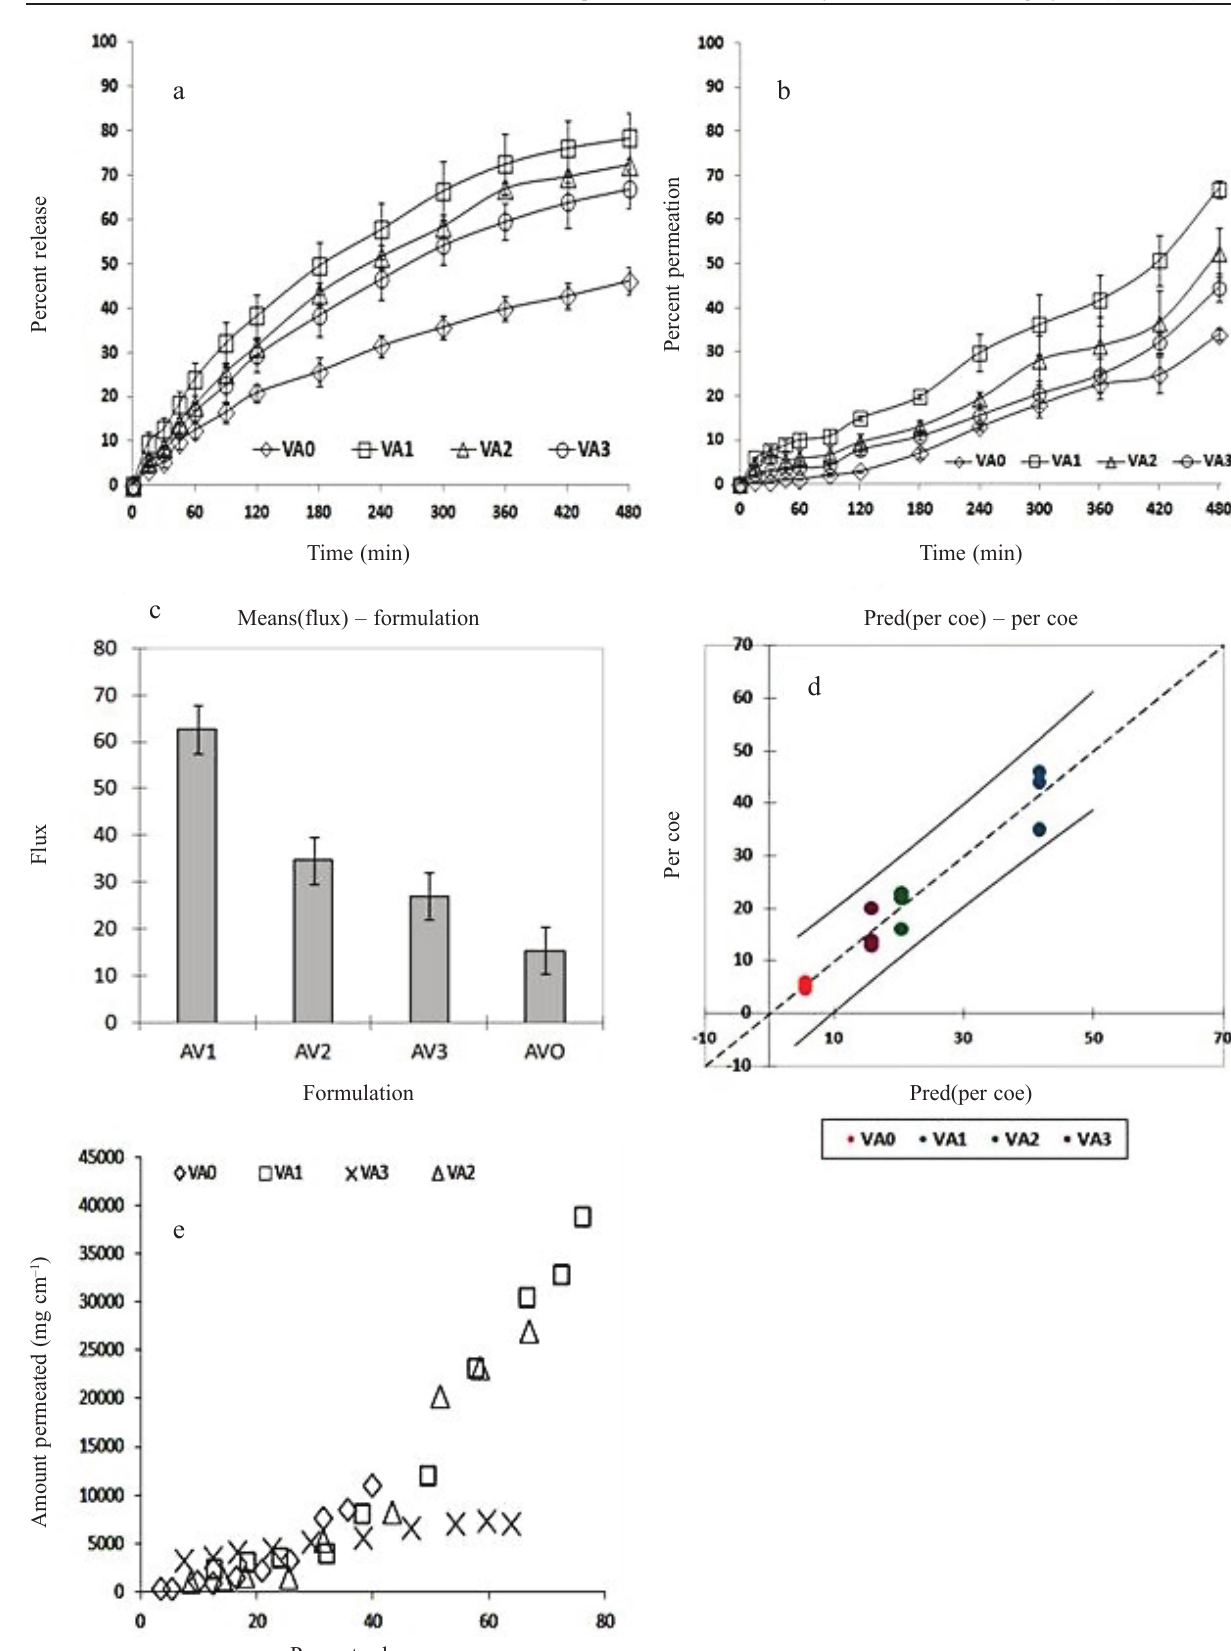
Fig. 3 – In vitro dissolution (a), Ex vivo buccal permeation (b), J observation vs. predicted permeation coefficient (d), correlation study between in vitro release and ex vivo buccal perme- ation of VAL and film